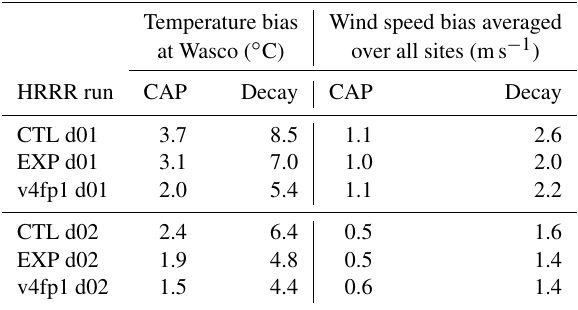
Table 3. Mean temperature and wind speed biases during the CAP and Decay periods averaged up to the mean ridge height. The wind speed biases are an average over all seven stations with wind profile